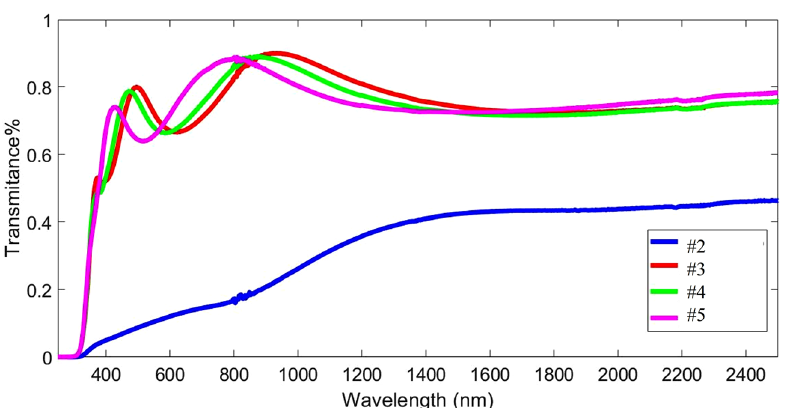
Figure 6. The transmittance spectra of prepared NiO thin films on quartz substrate with different annealing